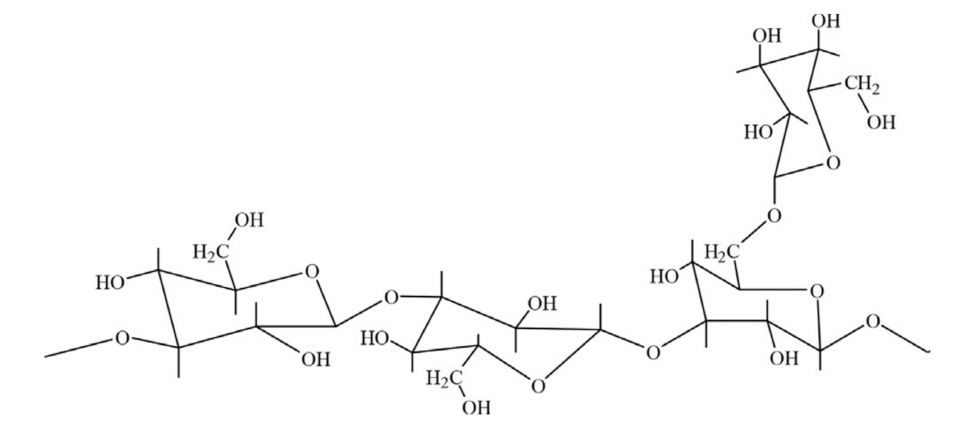
Figure 6. Chemical structure of an schizophyllan. Reprinted from [37]. Copyright @Elsevier